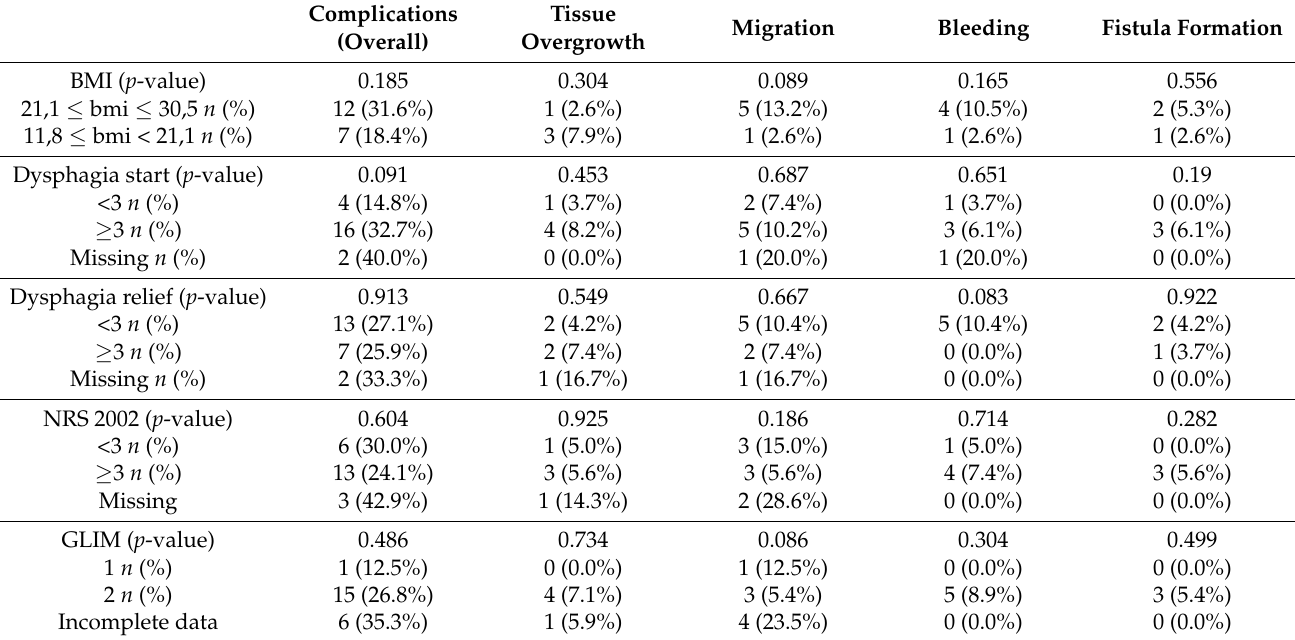
Figure 2. Survival curve of patients with malignant stenosis (overall, subdivided in relation to the median cut-off values of BMI and NRS 2002). Table 3. Patient’s nutritional status and complications of